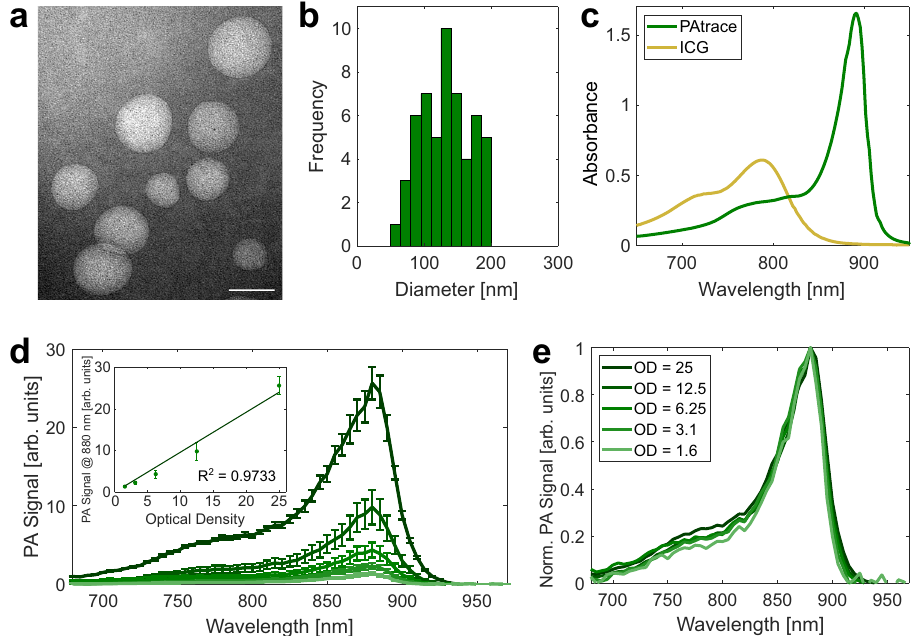
Fig. 2 PAtrace characterization. a Representative image of PAtrace TEM (scale bar 100 nm), which measured b a size distribution of 130 (±37) nm across all TEM images ( N = 5). c Spectral characterization of intact PAtrace (green) and ICG released from PAtrace by addition of 5% Tween 20 in water (gold) demonstrates that at equimolar concentrations, PAtrace yields an absorbance spectrum that is red-shifted, narrower, and of increased peak absorbance compared to monomeric ICG. d PA imaging of serial dilutions (25 – 1.6 OD; fl uence 0.3 – 0.9 mJ/cm 2 ) of PAtrace exhibits a constant spectrum over varying concentrations, and (inset) peak PA signal remains linear with increasing OD (error bars indicate mean ± SD across three independent PA acquisitions), while e normalization of these PA spectra shows spectral stability (error bars removed for